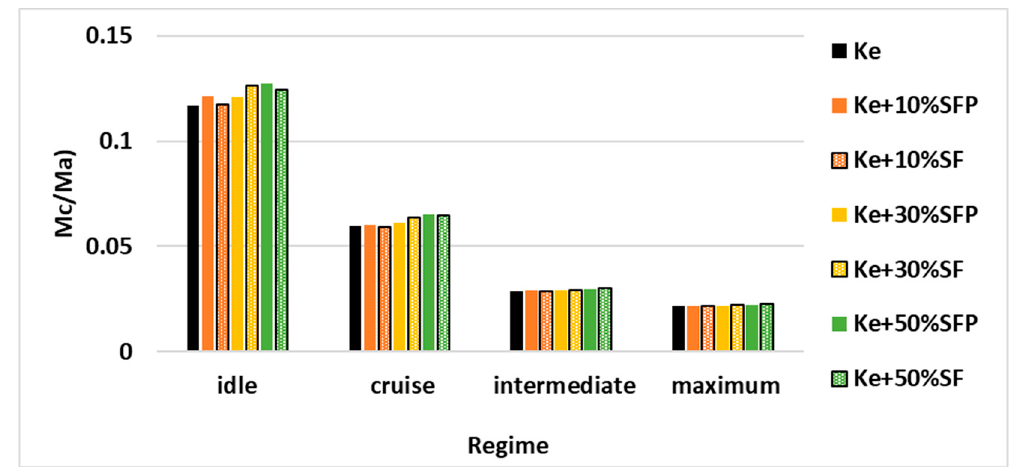
Int. J. Environ. Res. Public Health 2021 , 18 , x . . Figure 12. Variation of M(cid:4662) c / M(cid:4662) a for all four regimes and for all the tested fuel blends. Figure 12. Variation of Mc/ Ma for all four regimes and for all the tested fuel blends.